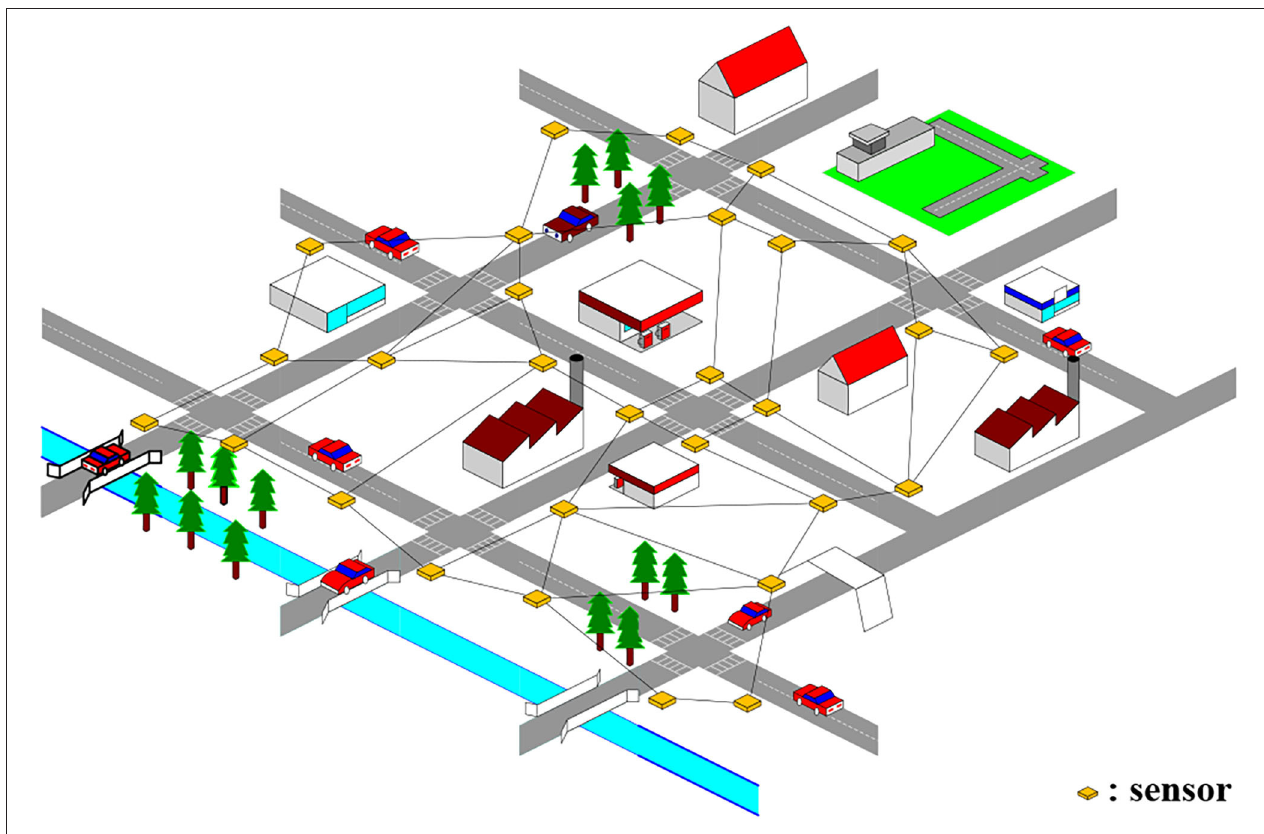
FIGURE 1 | An example of topology graph of traffic network.